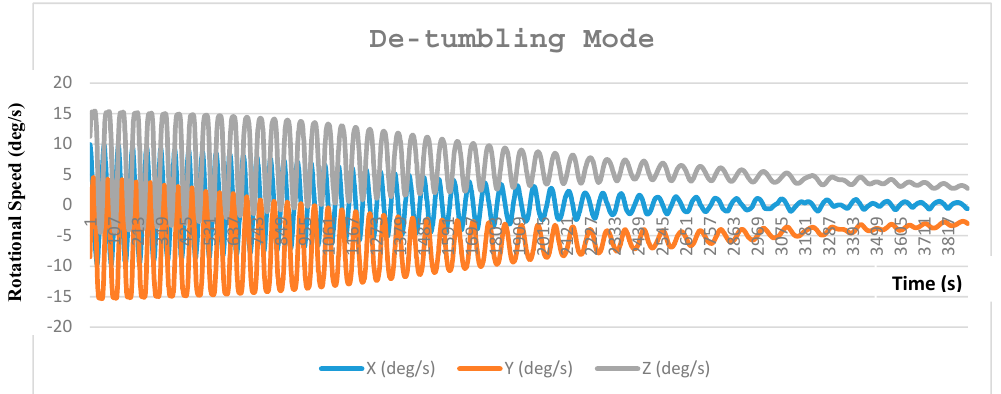
Figure 19. Results of the de-tumbling mode.